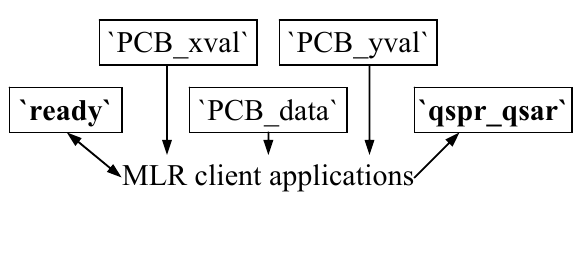
Figure 3. MLR MDF QSPR